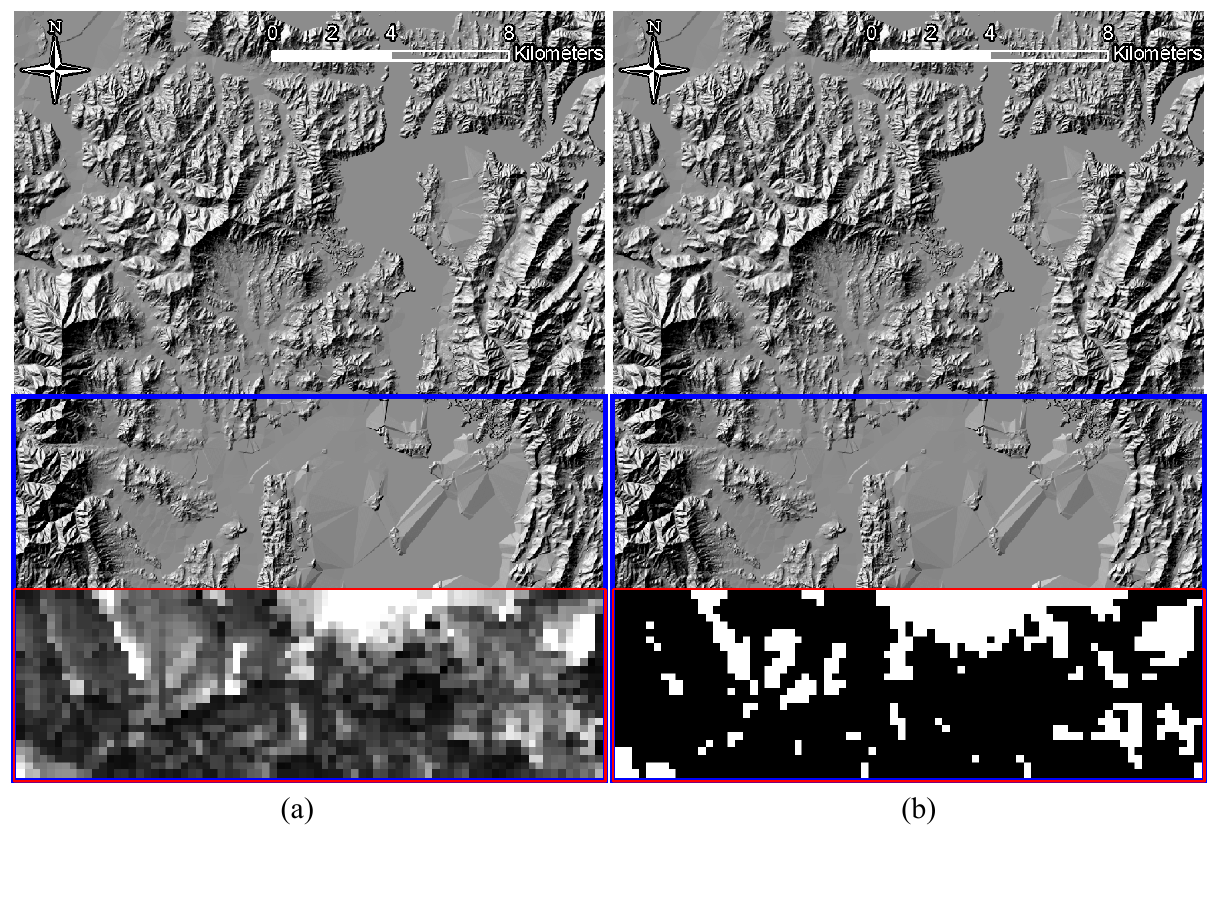
Figure 11. Conditions for TOD Locations. (a) The viewshed analysis result for each pixel (The bright zone represents the location of the larger viewshed in the infiltration zone). (b) The final candidate locations for TOD setups (white zone: >40% viewshed, black zone: <40% viewshed in the infiltration